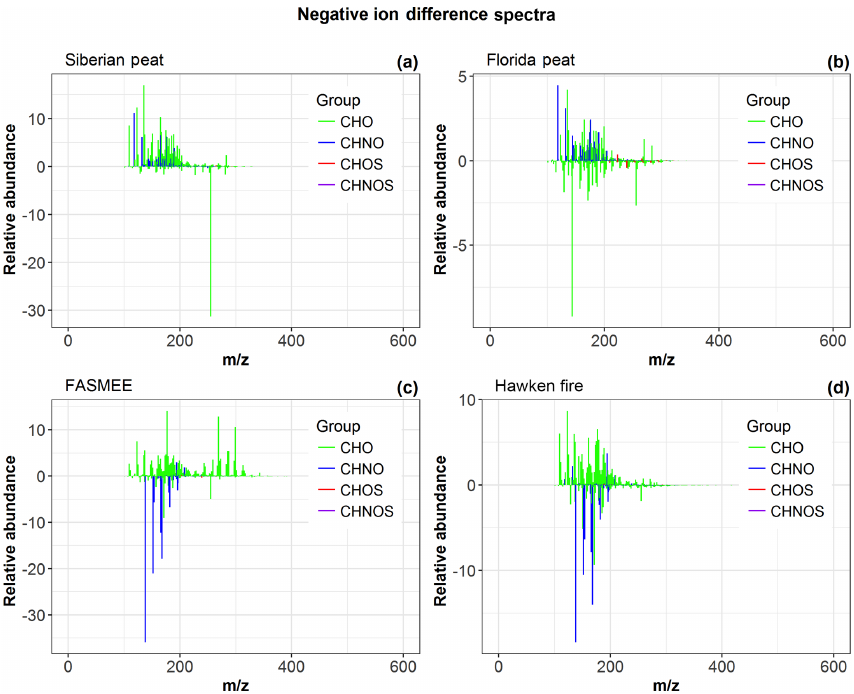
Figure 5. Ultrahigh-resolution mass spectrometry difference mass spectra for WSOC from the combustion emissions from the combustion of the representative fuels. (a, b) – smoldering fuels (peats); (c, d) – flaming